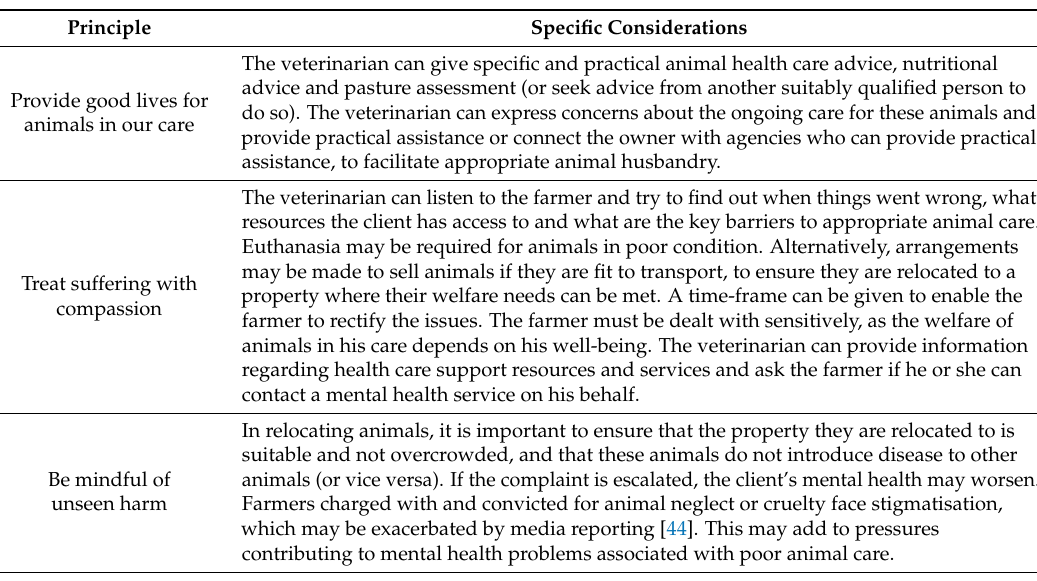
Table 3. Fraser’s “practical” ethic principles applied to farmer neglecting stock